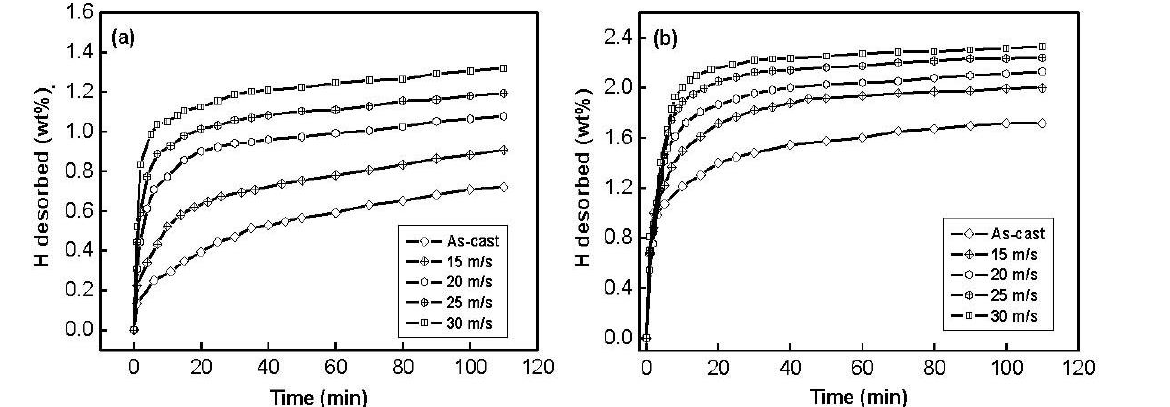
alloy; ( b ) Co alloy. 0.1 0.4